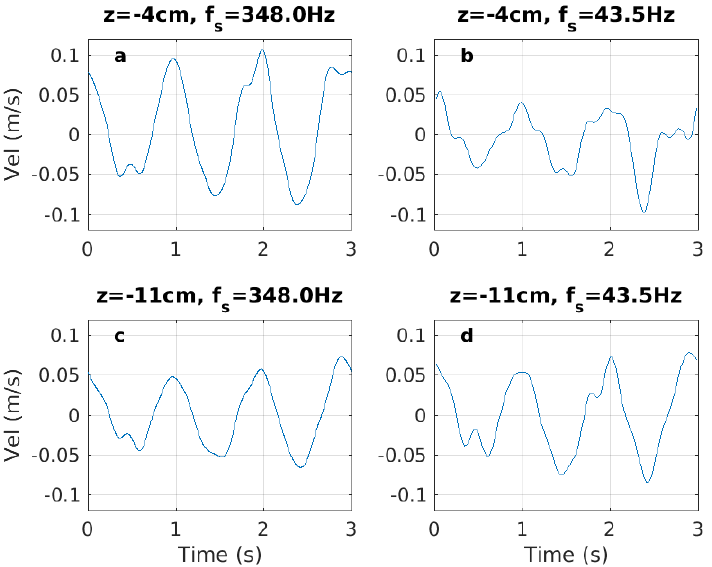
Figure 11. Low-pass filtered PIV-velocity time series for same two depths and two PIV-sampling frequencies as in Figure 10 above. In each case, data with frequencies over 5 Hz are now removed. Left panels ( a , c ) use a sample rate of 348 Hz. Right panels ( b , d ) use a sample rate of 43.5 Hz. Top panels ( a , b ) show velocities at 4 cm below mean water level (MWL). Bottom panels ( c , d ) show velocities at 11 cm below MWL